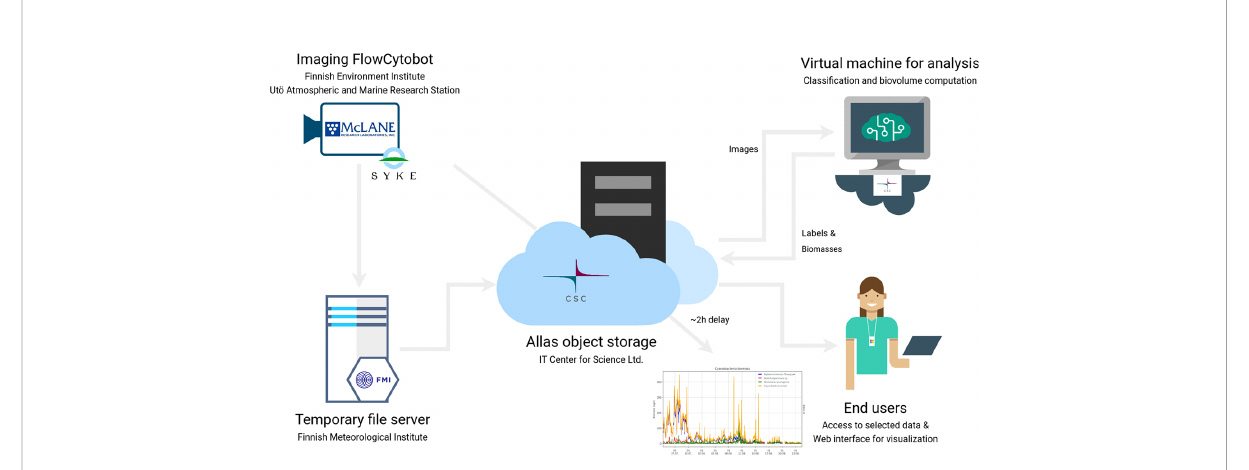
FIGURE 4 Scheme of the automated data fl ow and the subsequent data processing